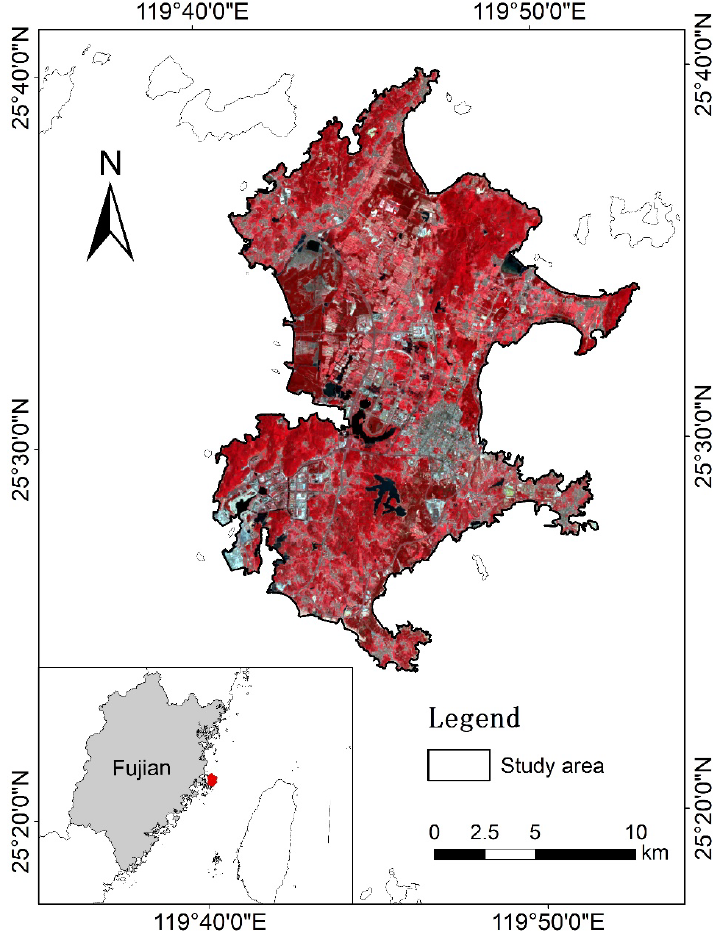
Figure 1. Location of Haitan, Fujian, China and its composite Landsat image (2021).